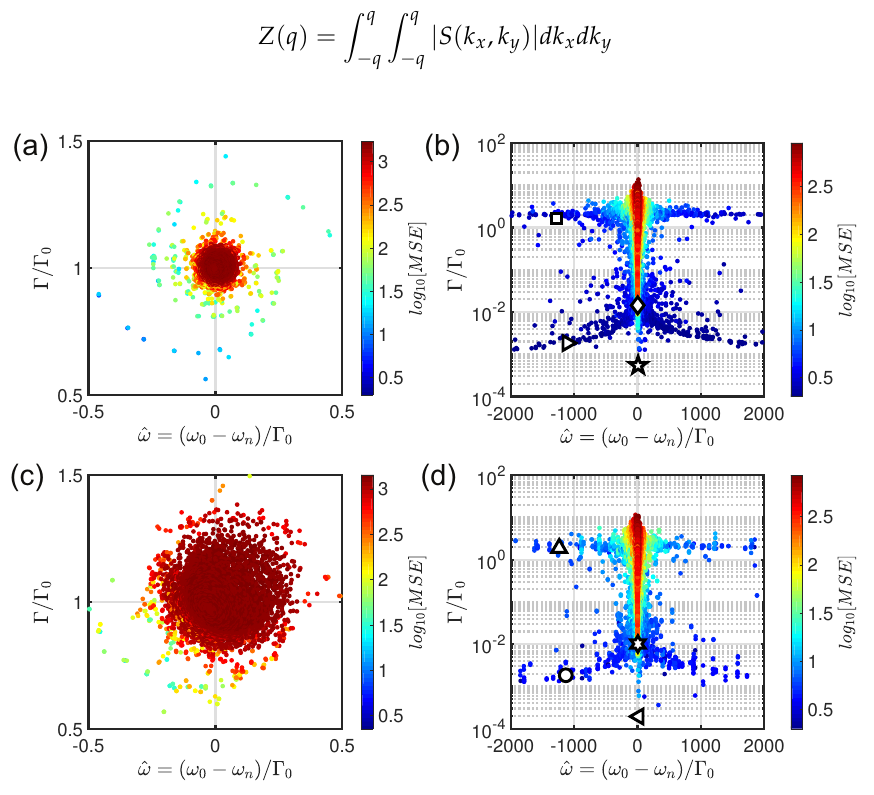
Figure 3. Eigenvalues of the Green’s matrix (7) are shown by points on the complex plane for 1630 electric point dipoles arranged in a Poissonian configuration (panel ( a , b )) and elliptic curve geometry (panel ( c , d )), respectively. The EC point pattern is shown in Figure 1b. Specifically, panels ( a , c ) and panels ( b , d ) refer to low ( ρλ 2 = 0.01) and high ( ρλ 2 = 50) optical density, respectively. The data are colored according to the log values of the MSE. The different markers identify representative 10 scattering resonances displayed in Figure 4. For the traditional uniform random configuration a total of at least 5 × 10 4 eigenvalues for each optical densities are